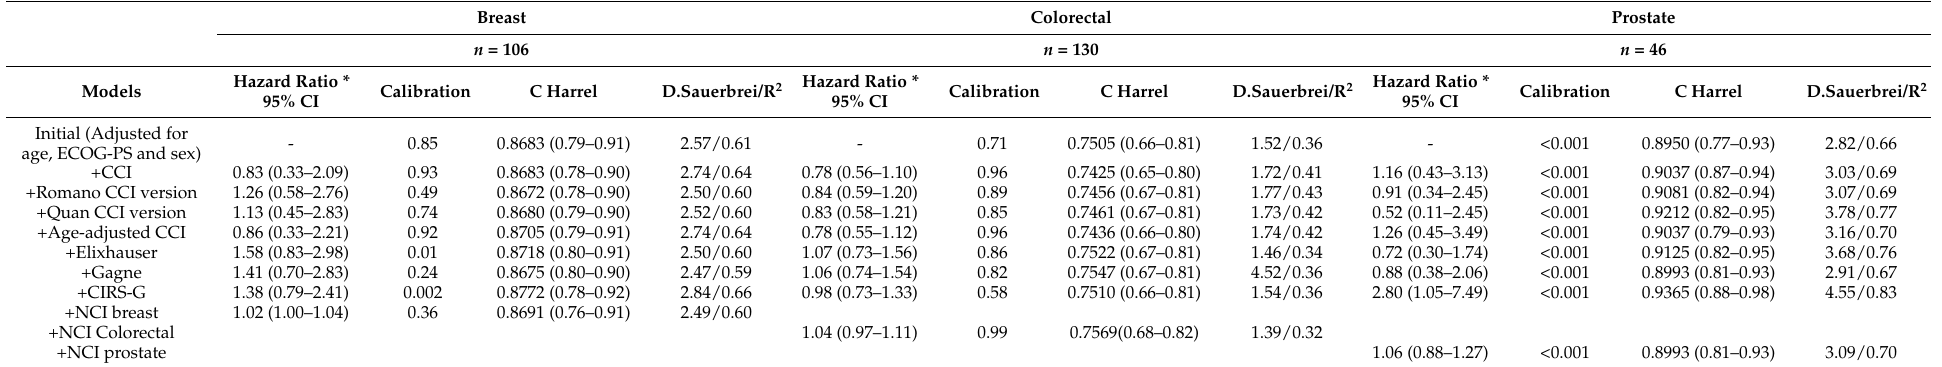
Table 3. The association of each comorbidity index with one-year mortality and the indices’ calibration and discriminant ability by cancer group.